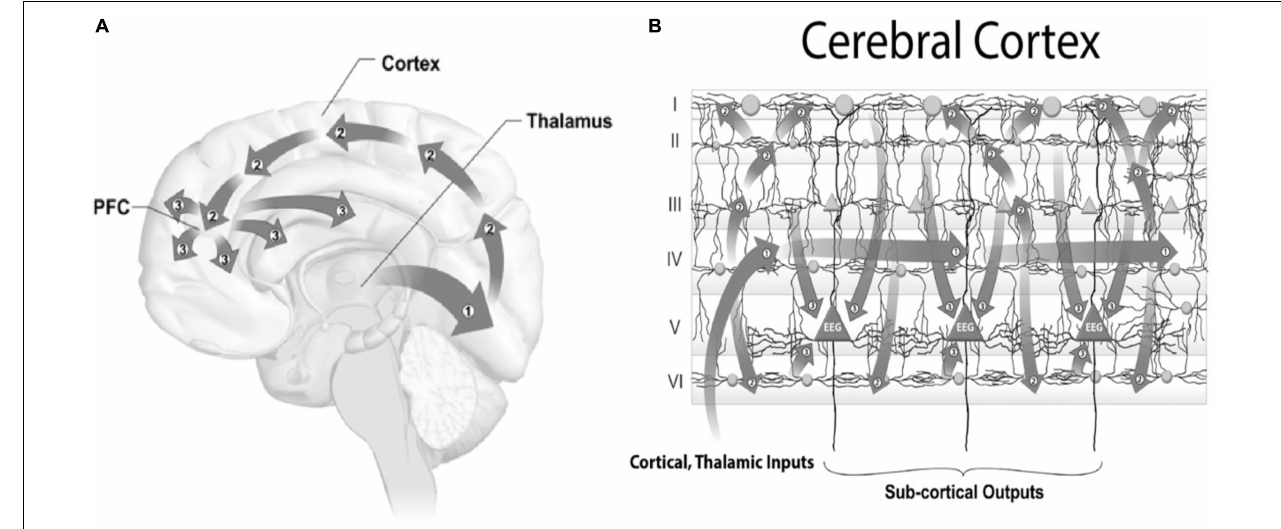
FIGURE 10 | (A) Conscious perception occurs in three waves from thalamus, for vision (Wave 1) to V1 in the back of the brain, (Wave 2) is feed-forward to front of brain, and (Wave 3) global broadcast from front of brain which correlates with consciousness after several hundred milliseconds. (B) Three waves in cortex. Inputs to 6-layered cortex go (Wave 1) to layer IV, then (Wave 2) to layers I, II, III and VI, and finally (Wave 3) converging on layer V giant pyramidal neurons.